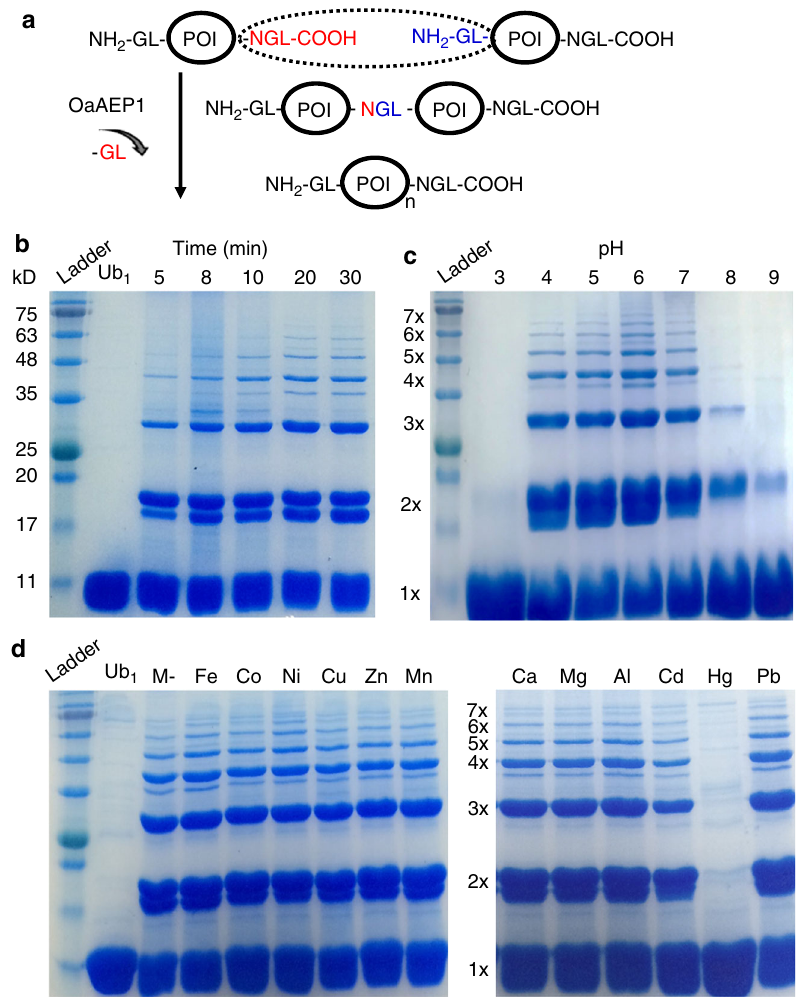
Fig. 1 Protein polymerization by OaAEP1. a Principle of OaAEP1-alone for protein polymerization is based on a GL-POI-NGL protein unit in which an N-terminal NGL (colored in red) reacts with a C-terminal GL (colored in blue) and leads an NGL linkage. b – d The PAGE gel results of ubiquitin polymerization indicate the formation of a protein polymer mixture with a varied length under different conditions. The reaction is fast (completed in 20 min) with the formation of protein polymer at least up to a pentamer ( b ). The polymerization is robust under acidic pH from 4 to 7 ( c ), as well as in the presence of most biologically-relevant metal ions ( d ), except